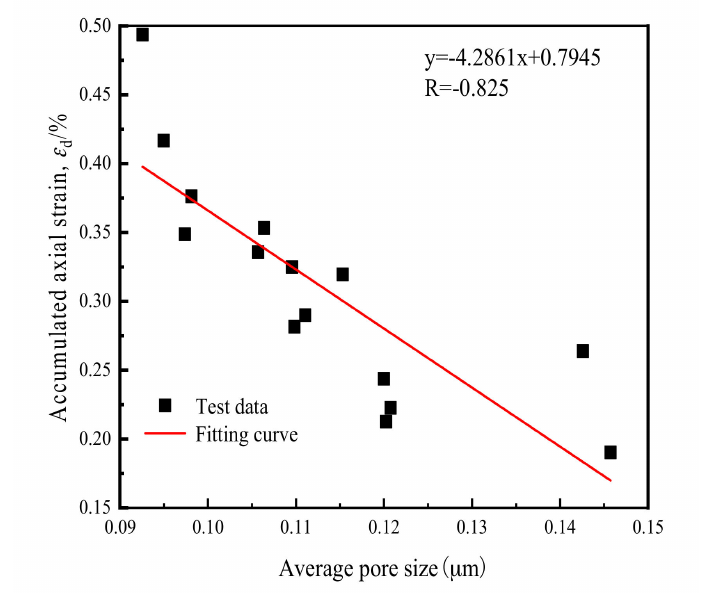
Figure 19. Correlation analysis of pore size and ε